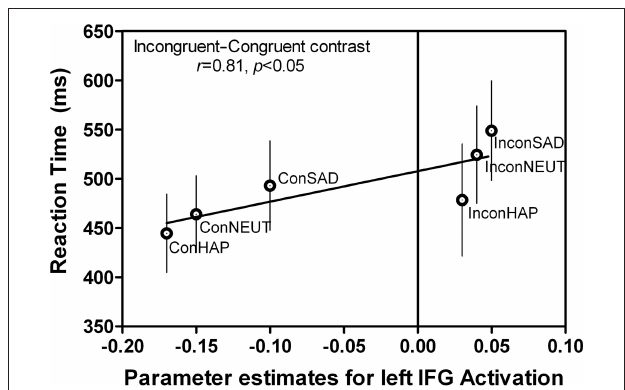
FIguRe 7 | Correlations between behavior and BOLD signal in left IFg. The same left IFG ROI ( Figure 5F : − 46, 36, 4) during the “Attend to Word” instruction, incongruent–congruent contrast showed a positive correlation between the RT and BOLD signal intensity. This indicates that additional resources in this region were recruited when the incongruent expressions were being reported. This graph is an average of all subjects’ RT and BOLD signal during each of the conditions ( n = 10). Error bars signify the standard error of mean